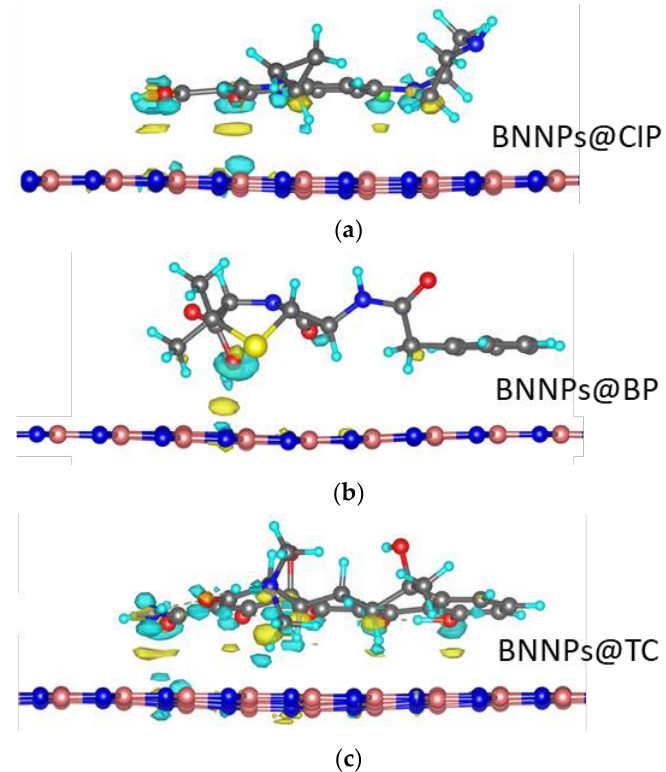
Figure 3. Electron density redistribution at the BN/AB interface. The loss and gain of charge are denoted by yellowish and bluish colors, respectively. The boron, nitrogen, carbon, oxygen, and hydrogen atoms are marked by green, gray, brawn, red, and beige colors, respectively. The isosurface constant value is 0.01 eV/Å .